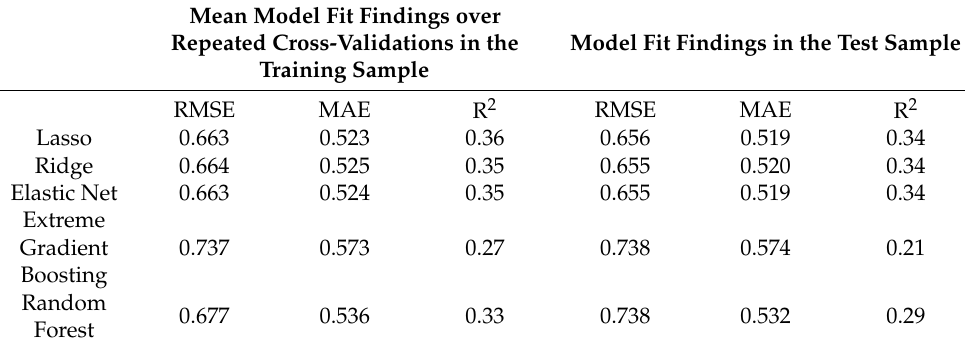
Table 3. Comparison of Five Machine Learning-based Regression Algorithms. Mean Model Fit Findings